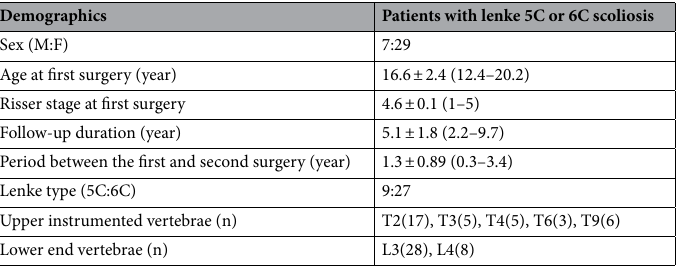
Table 1. General demographics of patients in this study. Data are presented as Mean ± SD/SE (Range).